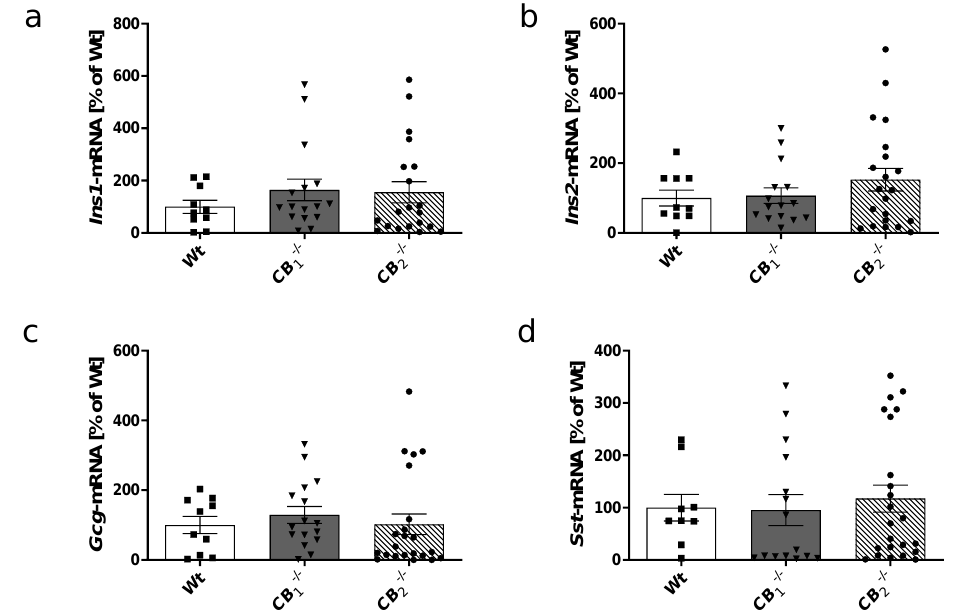
Figure 3. Transcript analysis by real-time RT-PCR of the pancreatic islet hormones ( a ) insulin 1 ( Ins1 ), ( b ) insulin 2 ( Ins2 ), (c) glucagon ( Gcg ), and ( d ) somatostatin ( Sst ) in pancreatic tissue of male and female wild-type (Wt) mice and cannabinoid receptor knockout mouse lines (CB 1 −/− , CB 2 −/− ). No statistically significant differences were measured. The expression level of Wt mice was defined as 100%. Values are presented as mean (± S.E.M.) with n = 9 – 23 mice per group; unpaired t -test.